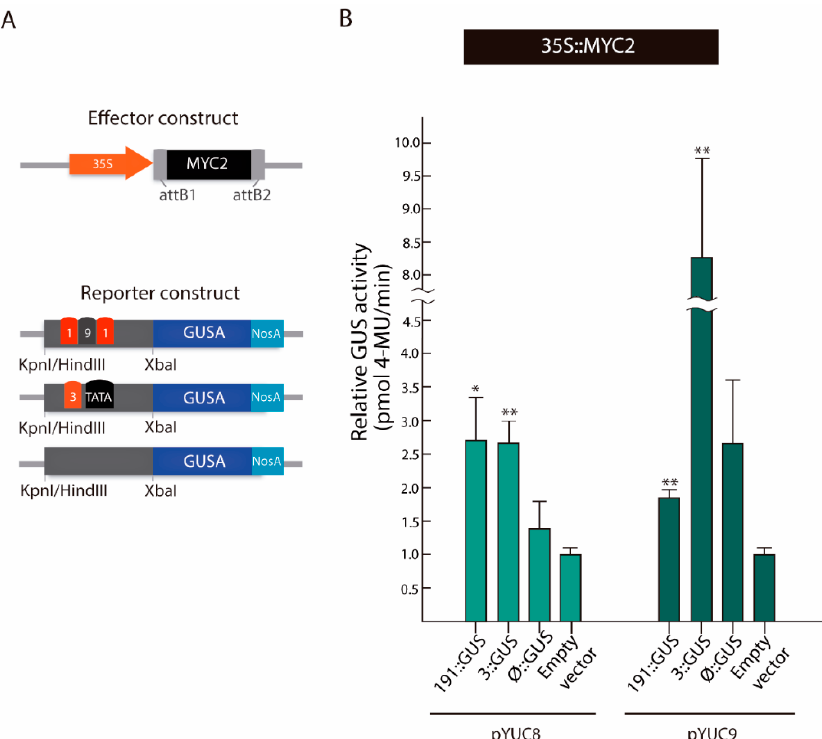
Figure 5. Transcriptional activity assay in A. thaliana mesophyll protoplasts. ( A ) Schematic representation of the effector constructs 35S::MYC2 and the - 191::GUS , - 3::GUS and - Ø::GUS reporter constructs used. ( B ) Fluorometric GUS activity quantification. The empty plasmid was employed as negative control. Here, GUS activity was relativized to the NAN reporter gene activity and normalized to the empty vector. Final GUS activation levels are expressed as pmol 4-methylumelliferone (MU)/min. Values are mean ± SE. To perform this experiment, three aliquots per protoplast suspension were inspected. Similar results were obtained in two independent experiments. Asterisks indicate Student’s t -test significant differences (* p < 0.05, ** p < 0.01).